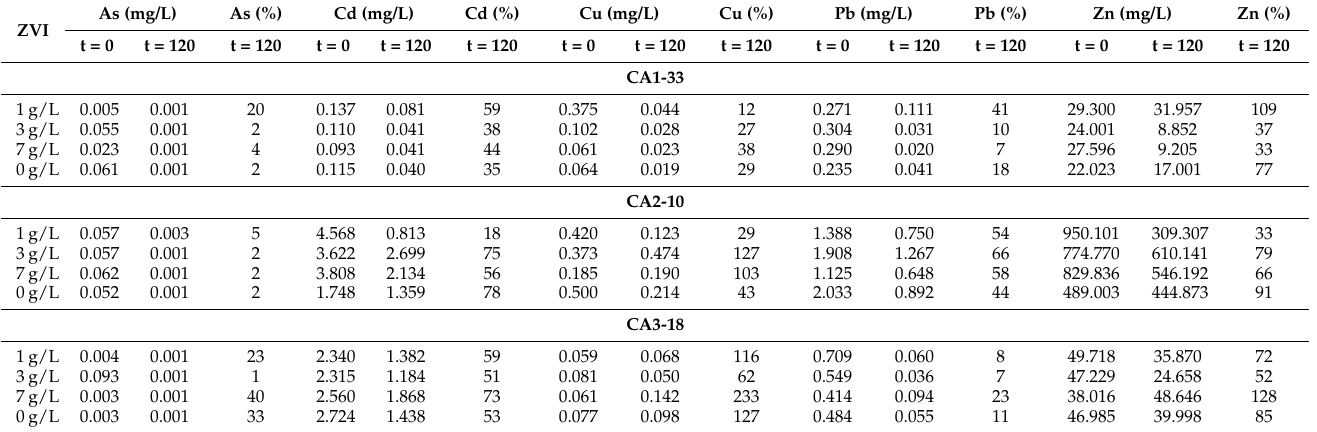
Figure 8. Changes in the As contents (%) in the soluble phase of samples, over 120 days of the remediation batch tests after the injection of nZVI suspension (concentrations of 0, 1, 3, and 7 g/L). Table 4. Comparison between the initial contents of metals in the interstitial water of homogenized samples before injection of nZVI (t = 0) and their final contents, after 120 days (t = 120). For each ele- ment, values are given in concentrations (mg/L) and in % calculated as [mg/L] t=120 days /[mg/L] t=0